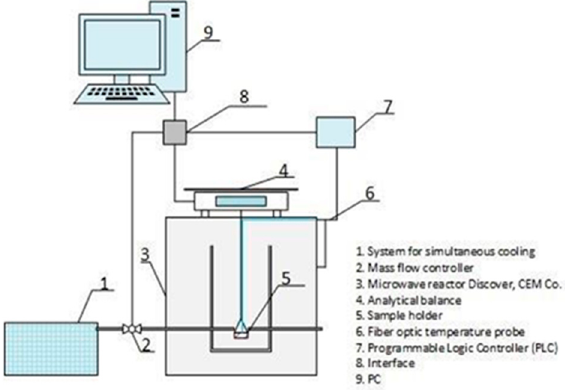
Figure 7. Scheme of the modified microwave device.